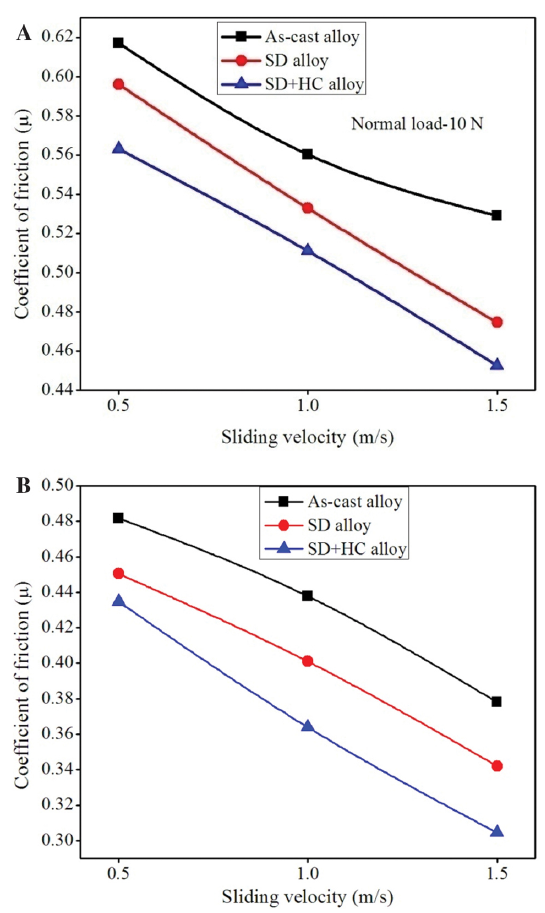
Figure 7: Coefficient of friction as a function of sliding velocity at load of (A) 10 N and (B) 50 N.